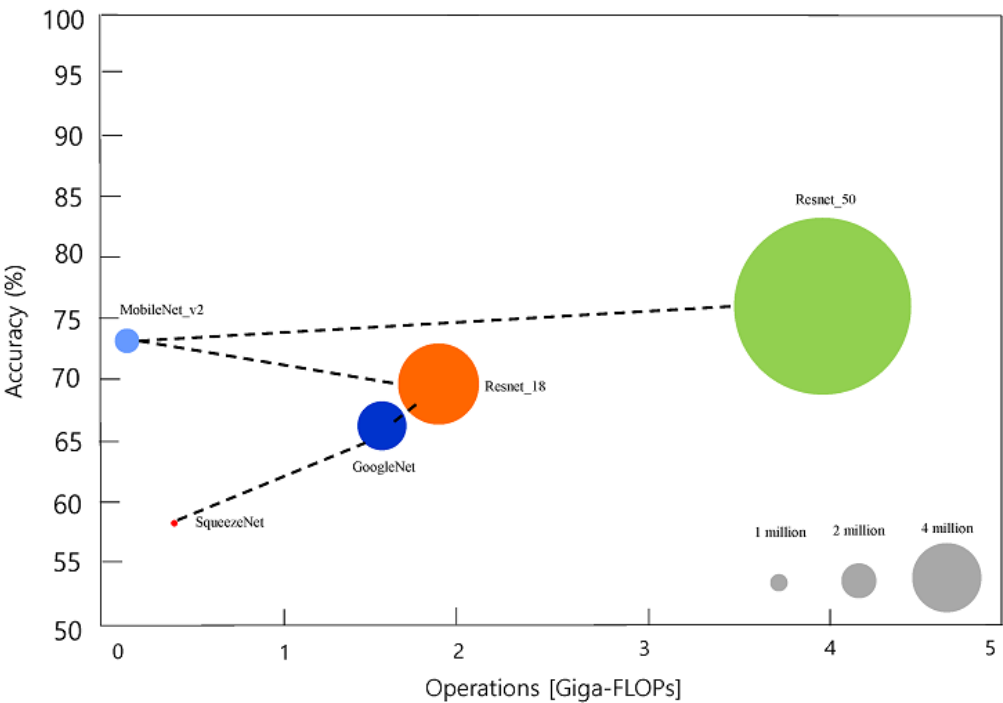
Figure 2. Relative speeds and accuracies of the different networks used in this study. B lack dash line represents for Pareto frontier: data from Benchmark Analysis of Representative Deep Neural Network Architectures [30].